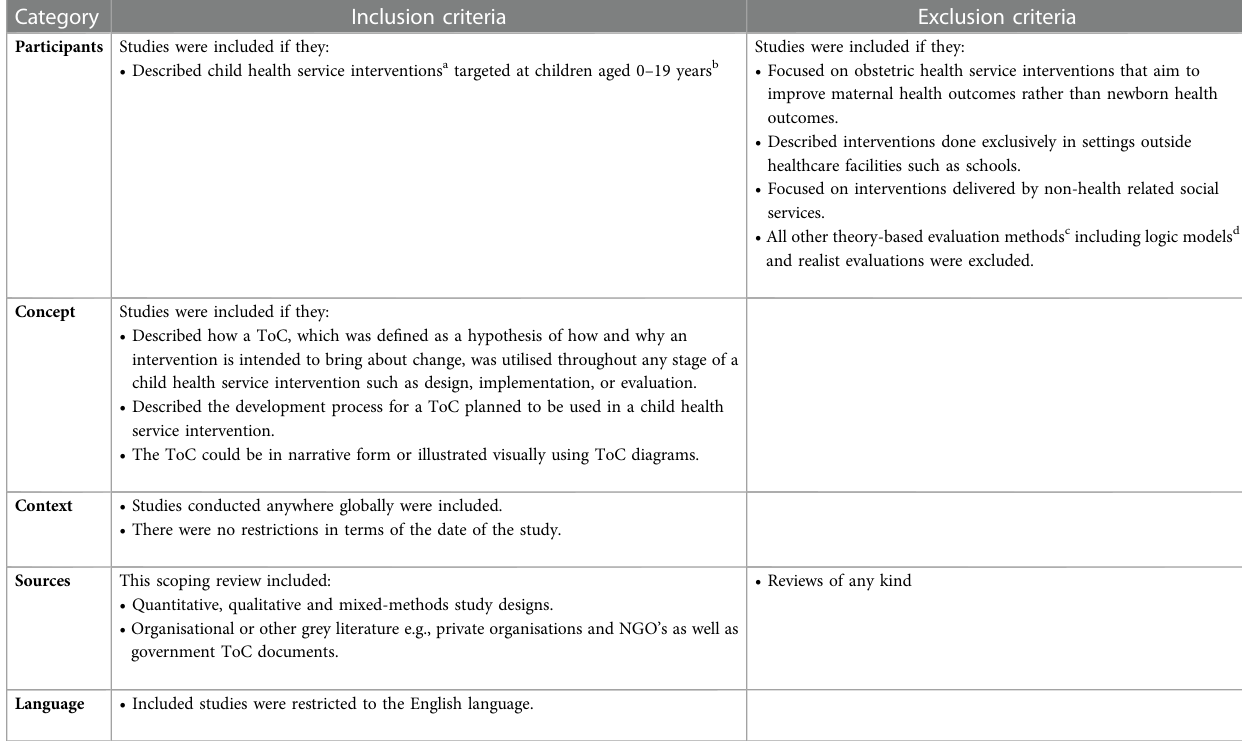
TABLE 1 Eligibility criteria for studies in this review.